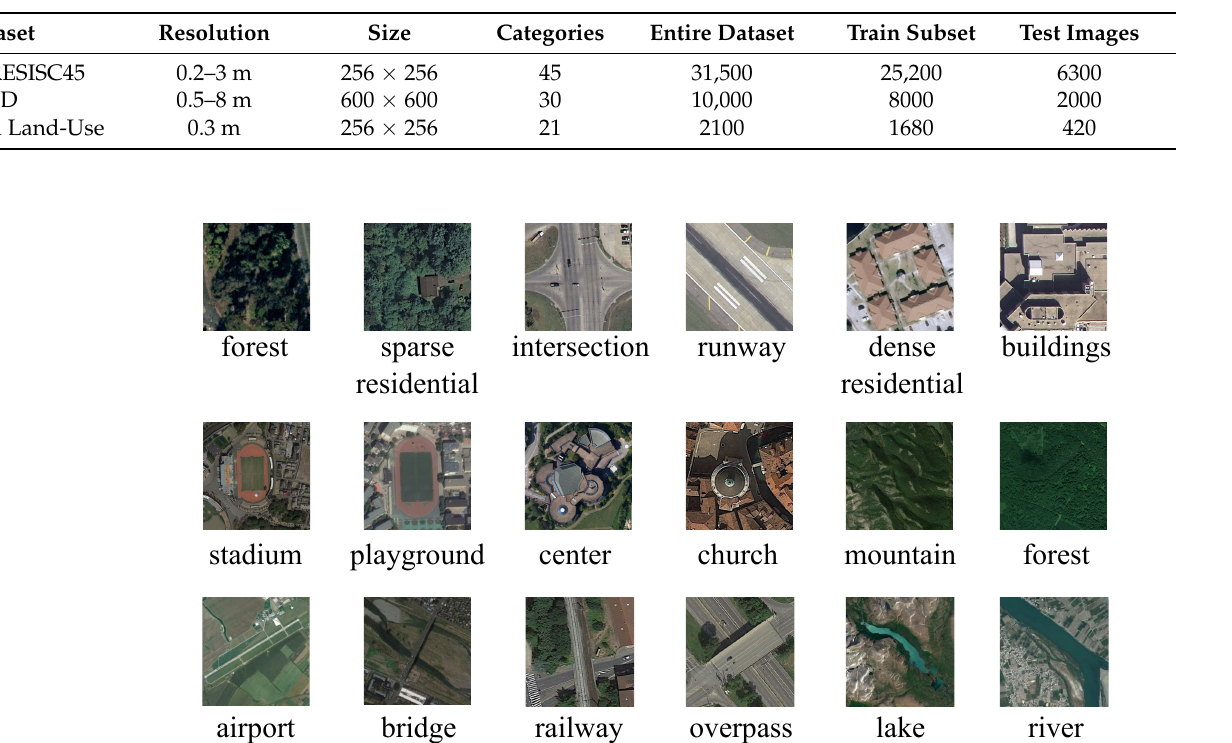
Figure 3. We present some example samples from three RSI scene classification datasets. The images in each row are UC Merced Land-Use, AID and NWPU-RESISC45, respectively. From these examples, we could observe that some categories have very high between-class similarities. For example, the forest and sparse residential area on the first line look very